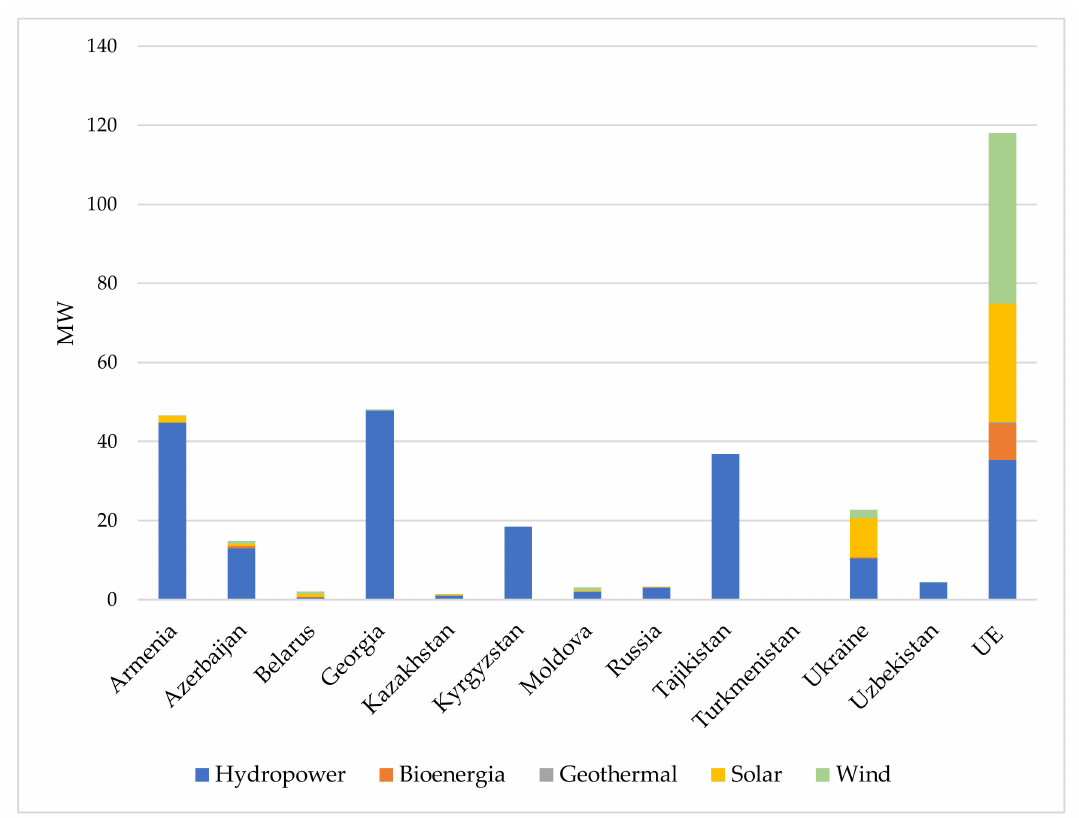
Figure 3. Energy production potential of individual renewable energy sources (RES) in 2019, as per area. Source: Own elaboration based on